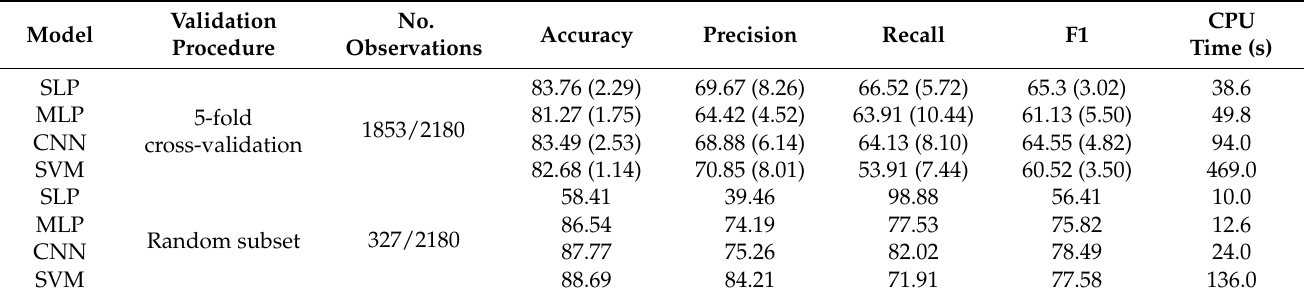
Table 3. Results of two validation procedures for single and multilayer perceptron (SLP and MLP), convolutional neural network (CNN) and support vector machines (SVM) with calibration dataset ( n = 2180). Number in brackets for stratified 5-fold cross-validation represents standard deviation of accuracy across